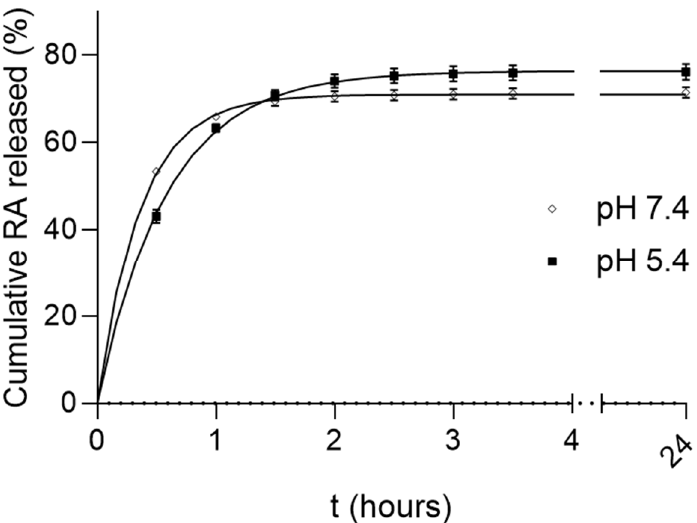
Figure 6. ( A ) UV-vis spectra of calibration samples in PBS. ( B ) Calibration line for RA in PBS. Error bars are not visible due to the low SD.